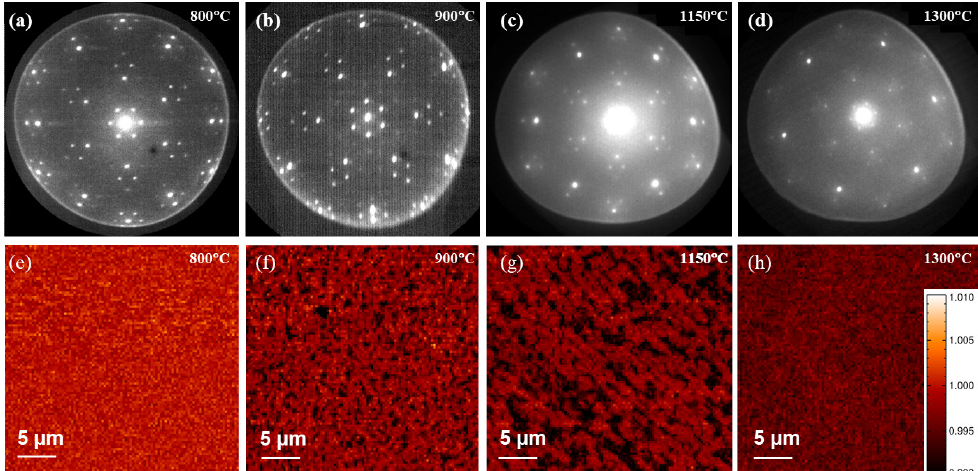
Figure 3. ( a – d ) Microprobe low-energy electron diffraction ( µ -LEED) patterns taken at electron energy of 50 eV ( a , b ) and 40 eV ( c , d ) and ( e – h ) 30 µ m × 30 µ m normalized reflectance maps of buffer layer samples with T Ar = 800 ◦ C ( a , e ), T Ar = 900 ◦ C ( b , f ), T Ar = 1150 ◦ C ( c , g ) and T Ar = 1300 ◦ C ( d , h ). T Ar are indicated in the up right corner of the respective images. The difference in reflectance between bare substrate and fully covered with buffer layer is ∼